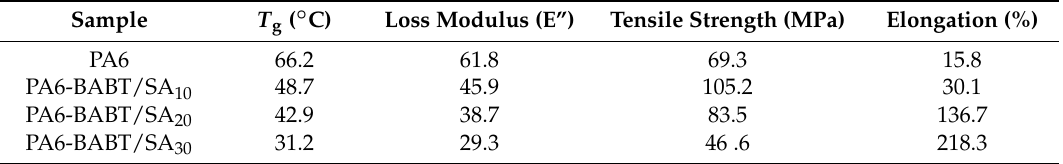
Table 5. Mechanical properties of PA6 and PA6-BABT/SA